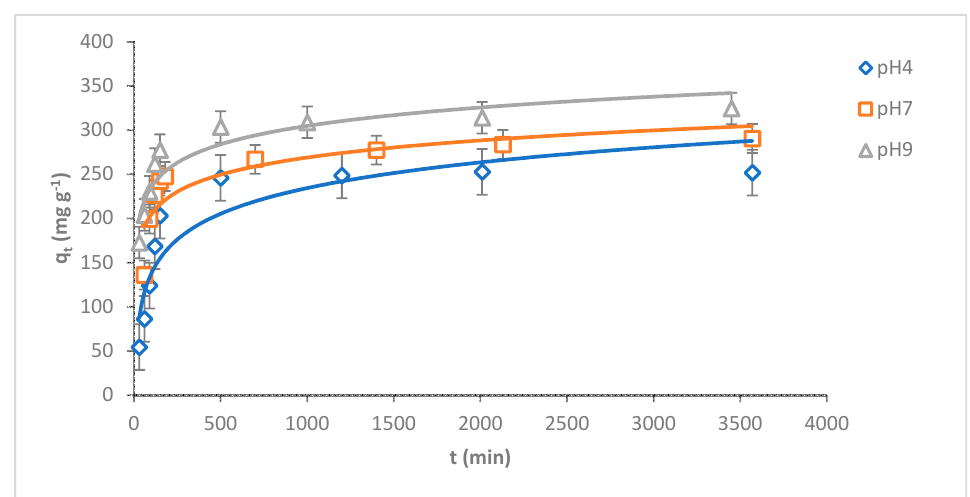
Figure 7. pH impact of MB dye adsorption onto O -CM-chitosan hydrogel at different time intervals (adsorbent dose 0.05 g, 50 mL of dye solution (1000 mg L − 1 ), at 25 °C).